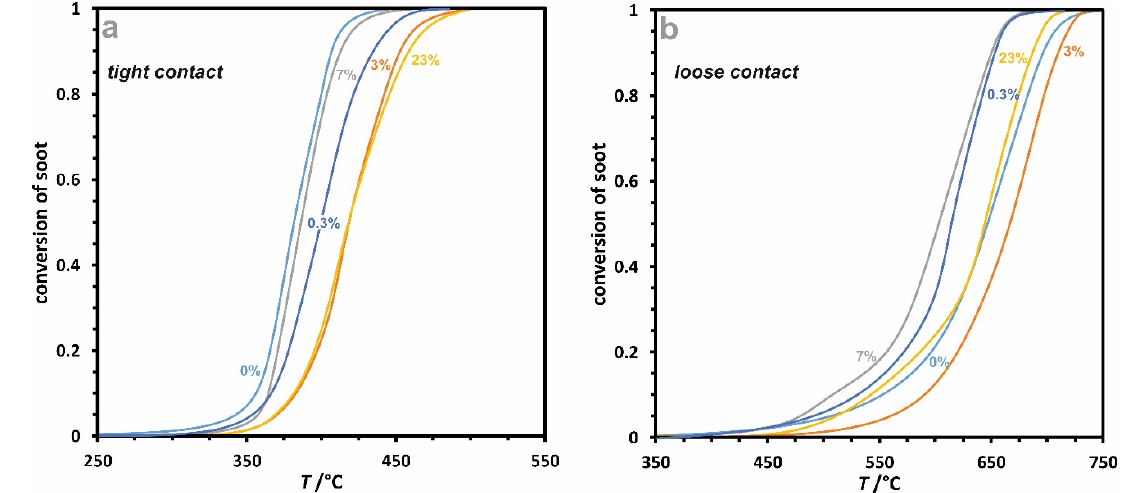
Figure 6. Oxidation of soot over the K-OMS-2 and Nb / K-OMS-2 catalysts in the tight ( a ) and loose ( b ) contact.